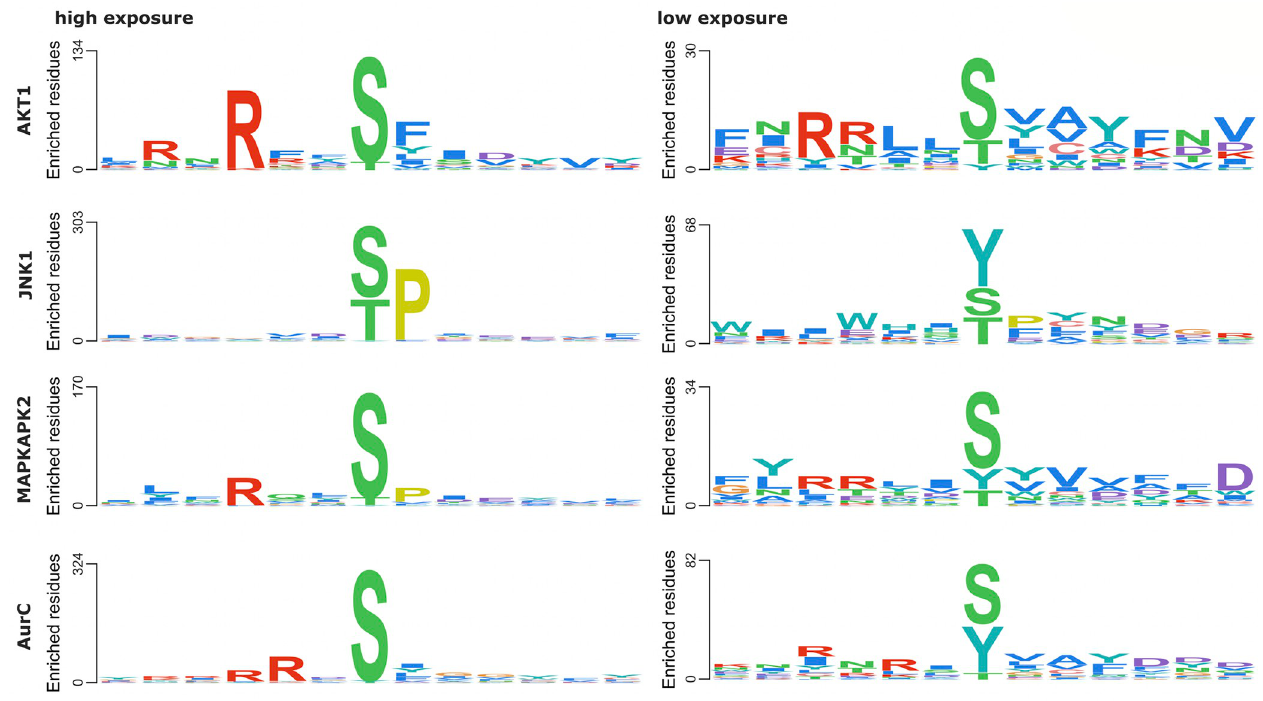
Fig 1. Different sequence profiles in exposed and solvent-excluded phosphosites (STY) as recognised by different kinases. The availability of accurate 3D models now allows for this direct mapping of sequence profiles onto structures and allows estimating their solvent accessibility. Extracted from Fig 3d of Bludau and colleagues